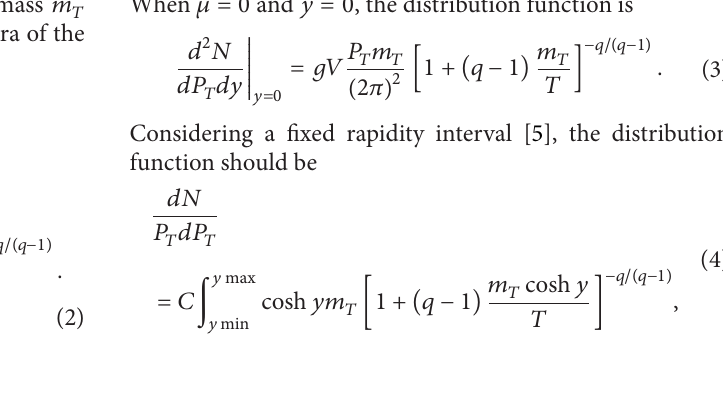
potential, respectively. In terms of the transverse mass 𝑚